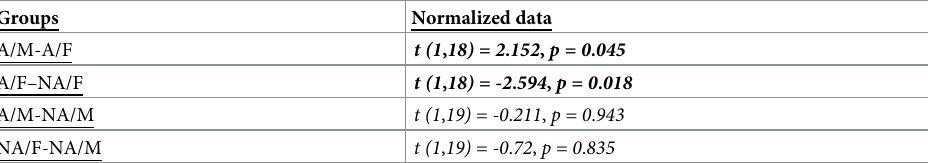
Table 2. Paired t-test results for normalized